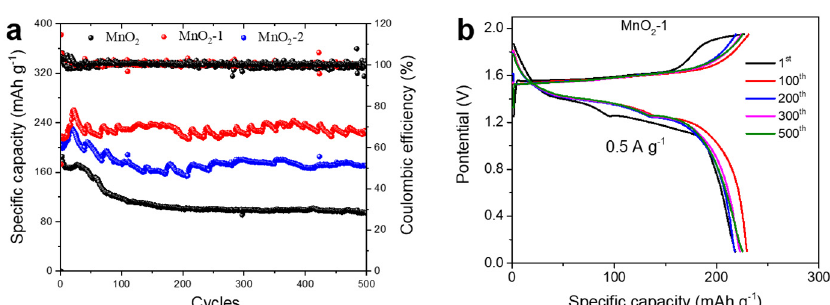
Figure 6. ( a ) Cycling performances of the three batteries at a current density of 0.5 A g − 1 in the potential range between 0.1 and 1.95 V; ( b ) electrochemical charge–discharge profiles of MnO 2 -1. Table 1. Electrochemical performance of the MnO 2 –agar cathode compared with those of different manganese oxide cathodes in recent studies. (mAh g − 1 )